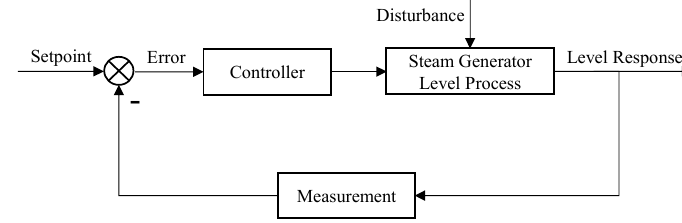
Figure 2. Diagram of the SGLCS.